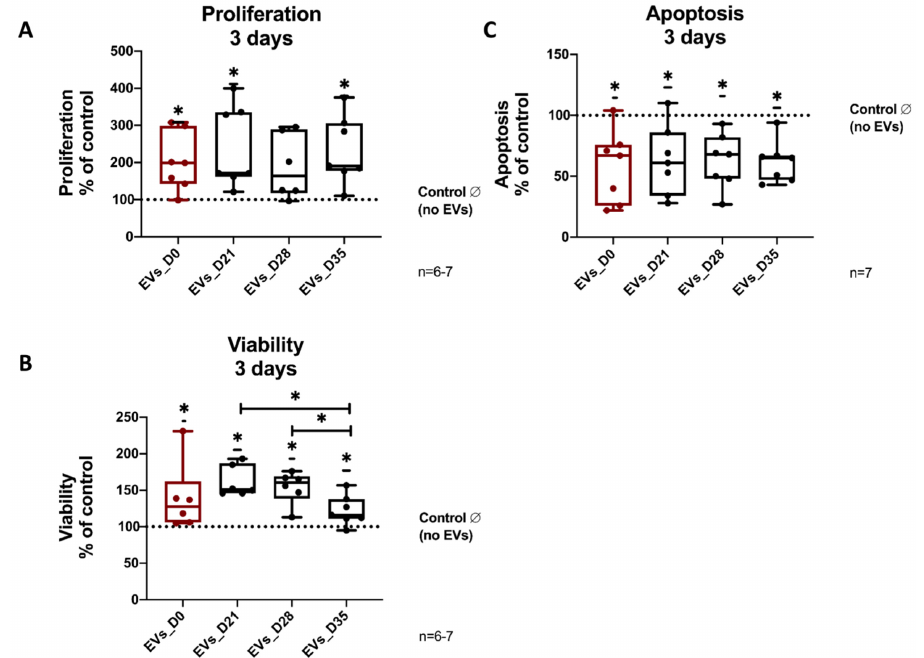
Figure 3. Effects of EVs derived from different stages of BMSC osteogenesis on naïve hBMSC proliferation, viability and apoptosis. ( A ) For proliferation analysis, naïve hBMSCs were stimulated for 3 days with the different EV groups or PBS (no EVs) in medium containing 1% EV-depleted FCS; n = 6–7. Analysis of viability ( B ) and apoptosis ( C ) of naïve hBMSCs after stimulation for 3 days with the different EV groups or PBS (no EVs) in medium containing 1% EVs-depleted FCS; n = 6–7. Results were calculated as percentage to the control group (no EVs, shown by the dotted line);